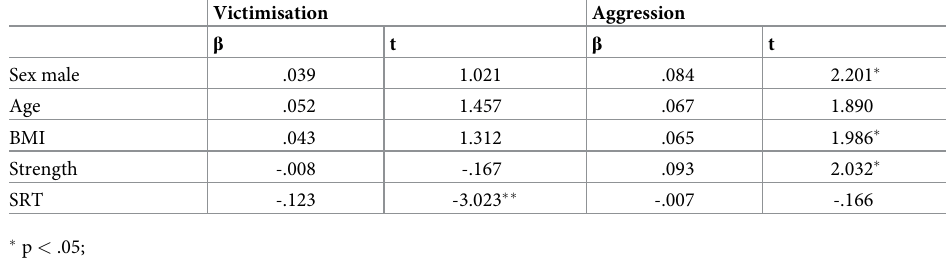
Table 5. Linear regression analysis with gender, age, BMI, strength and cardiorespiratory fitness as cross-sec- tional predictors of victimisation and aggression.